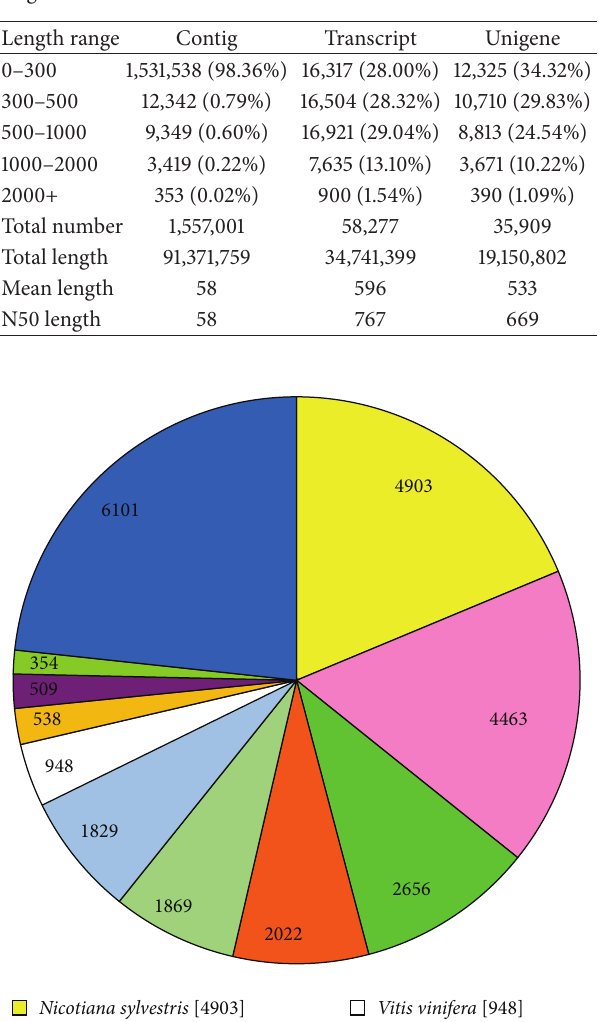
Figure 3: Comparative analysis of gene expression in Weiduoli and HVB-3. (a) A scatter plot of RPKM logarithmic values in libraries of Weiduoli and HVB-3. Each dot represents the RPKM value of a specific gene. The greater deviation from the diagonal slope shows a greater expression level of the gene in the corresponding material. (b) A scatter plot of the ratio of RPKM logarithmic numerical values of genes in Weiduoli and HVB-3. This plot graphically represents genes differentially expressed between Weiduoli and HVB-3. Blue dots represent genes that had significant difference and red dots represent genes where no significant difference was observed between Weiduoli and